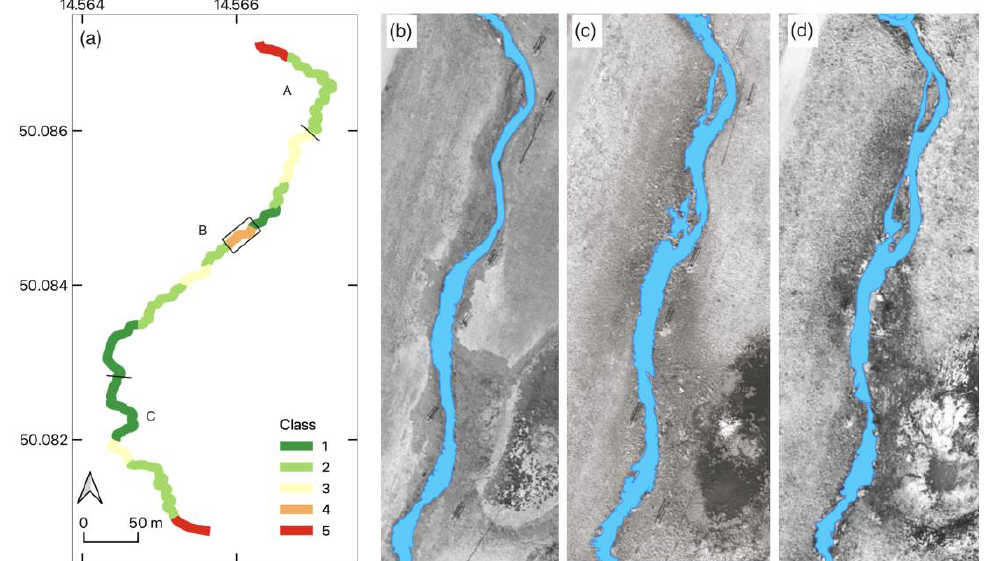
Figure 7. Stream wandering in the central segment HOS ( a ) after the completion of the restoration. ( b ) Bare riparian zone after the completion of the restoration in March 2016. ( c ) Initiation of stream wandering after the summer storm flood in June 2016. ( d ) Stabilized channel pattern after the first vegetation season, March 2017. Data: UAV monitoring, 2016 – 2017. In the LIP brook, the restored channel remained stable (Figure A3b). The first vege- tation season after the restoration (2019) lacked significant peak flows, so the riparian zone